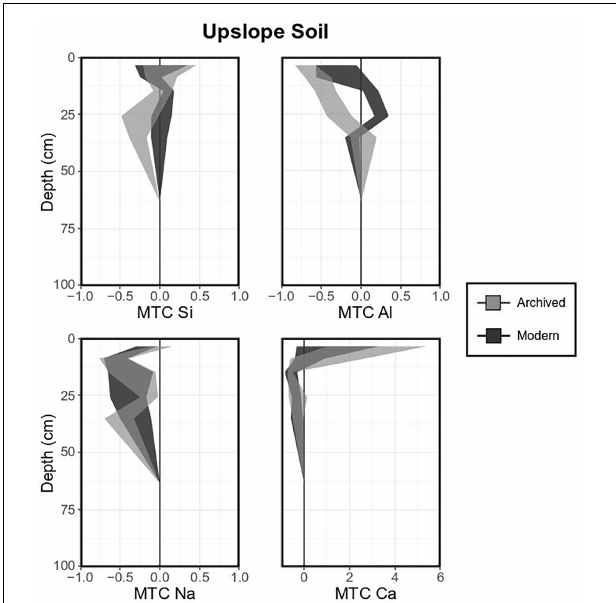
FIGURE 5 | Mass transfer coefficient (MTC) values of selected elements for a typical upslope soil (Spodosol). Light gray shaded areas indicate means and standard deviations for each element measured in 1996 (8 pits), dark gray shaded areas indicate means and standard deviations for each element measured in 2017 (3 pits).